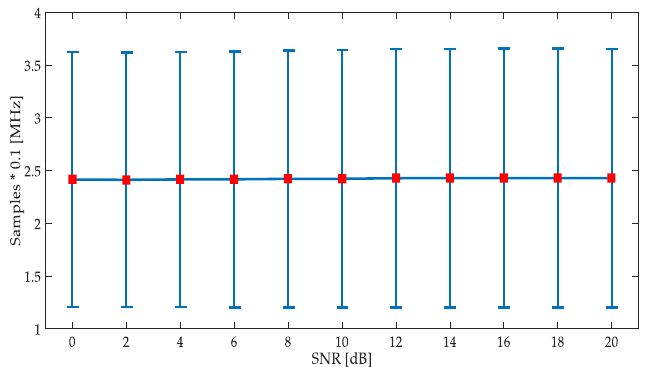
Figure 18. Study of frequency edge detection applying the second methodology.